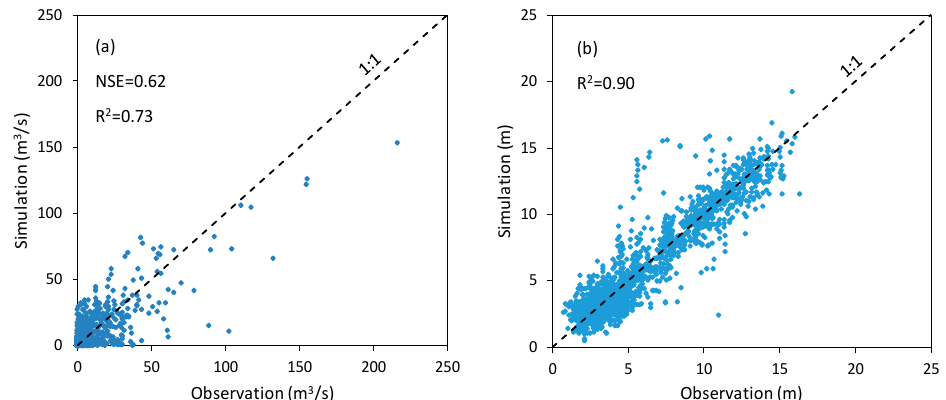
Figure 7. Model performance of ( a ) monthly flow simulations at all hydrologic stations and ( b ) groundwater depth simulations at all observation wells from 2002 to 2014 in the dynamic land use mode.